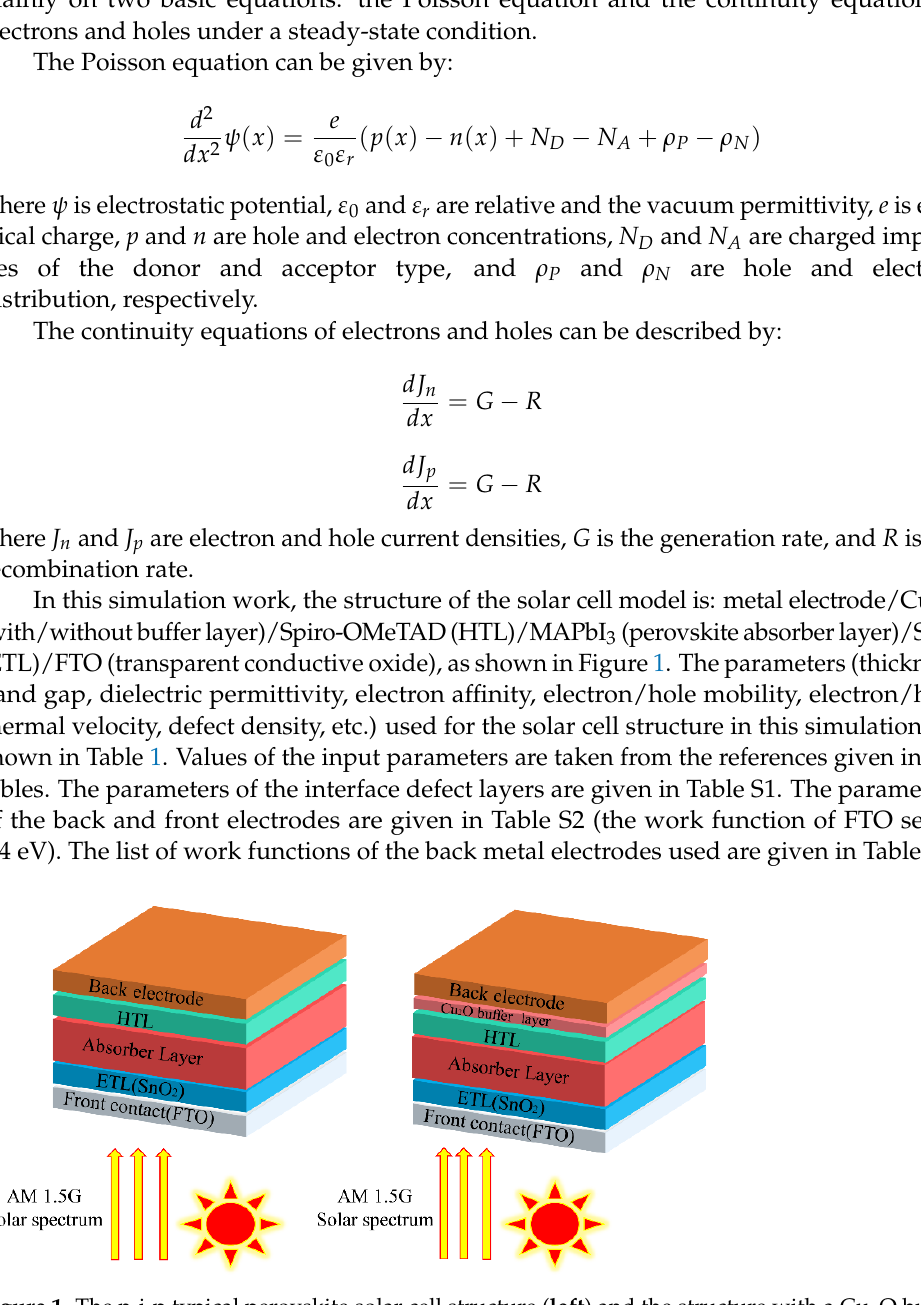
Table 1. Primary input parameters used for the simulation of perovskite solar cells. Parameters